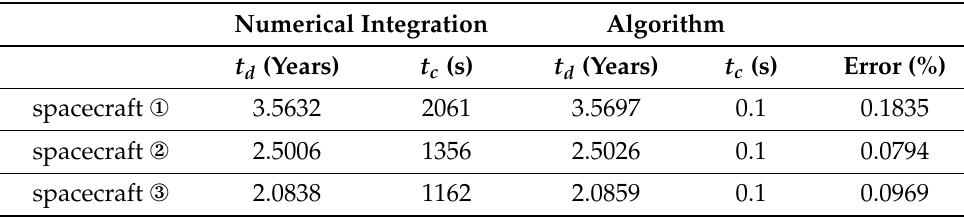
Table 3. Decay time t d and computation time t c for the three cases studied obtained through numerical integration (actual value) and the proposed algorithm (approximate